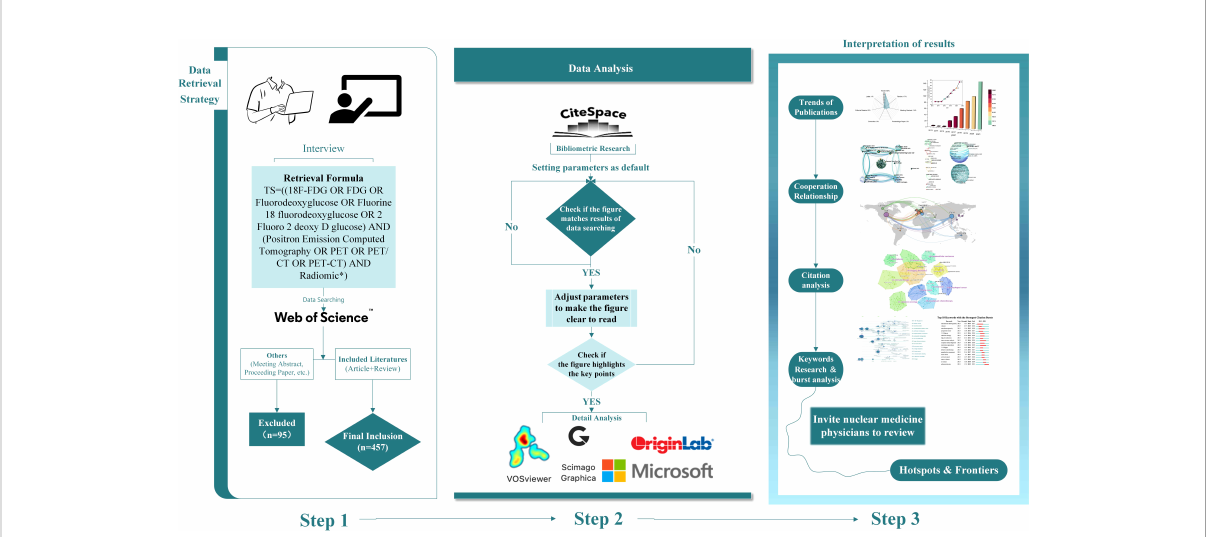
FIGURE 1 Flow chart of this bibliometric analysis. (Step 1) Data retrieval strategy of published literatures, showing the detailed process of screening and inclusion. (Step 2) Data analysis of this study, including bibliometric analysis and data processing. (Step 3) Interpretation of results, containing a brief view of results and the fi nal process of drawing